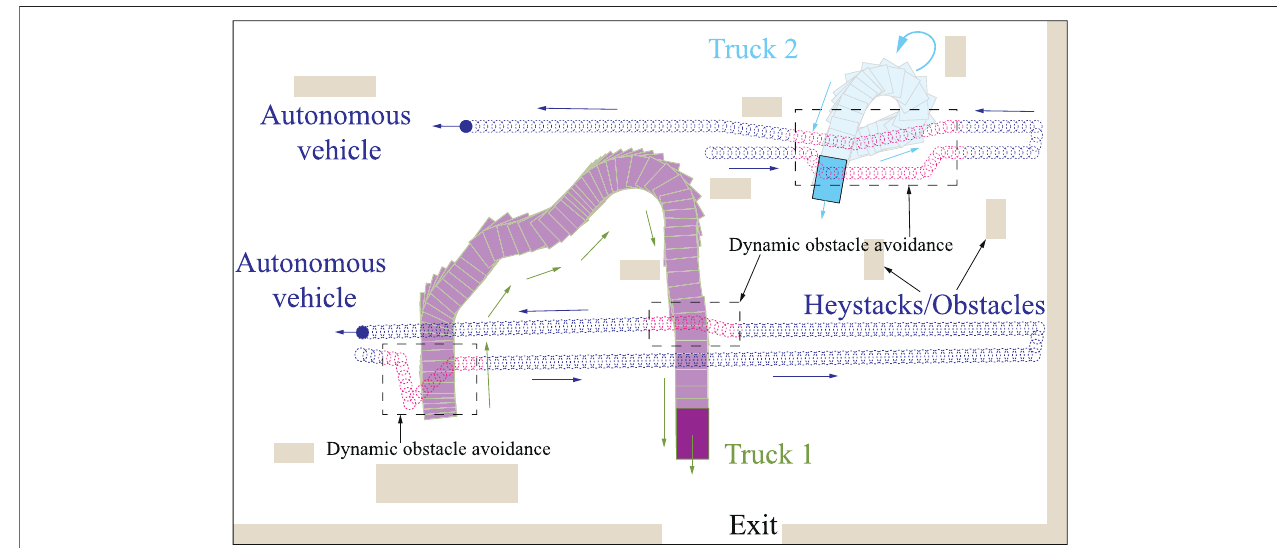
FIGURE12| Illustration ofautonomousvehicleCCPP navigationwithunknownand movingobstaclesinthereal-worldenvironment.Thedashed boxesdepictthe avoidance of the moving trucks.